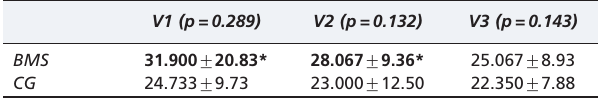
Table 3 - Between-group comparison of the superficial algometry means for all trigeminal branches. Thresholds at V1 and V2 (N = 50) were